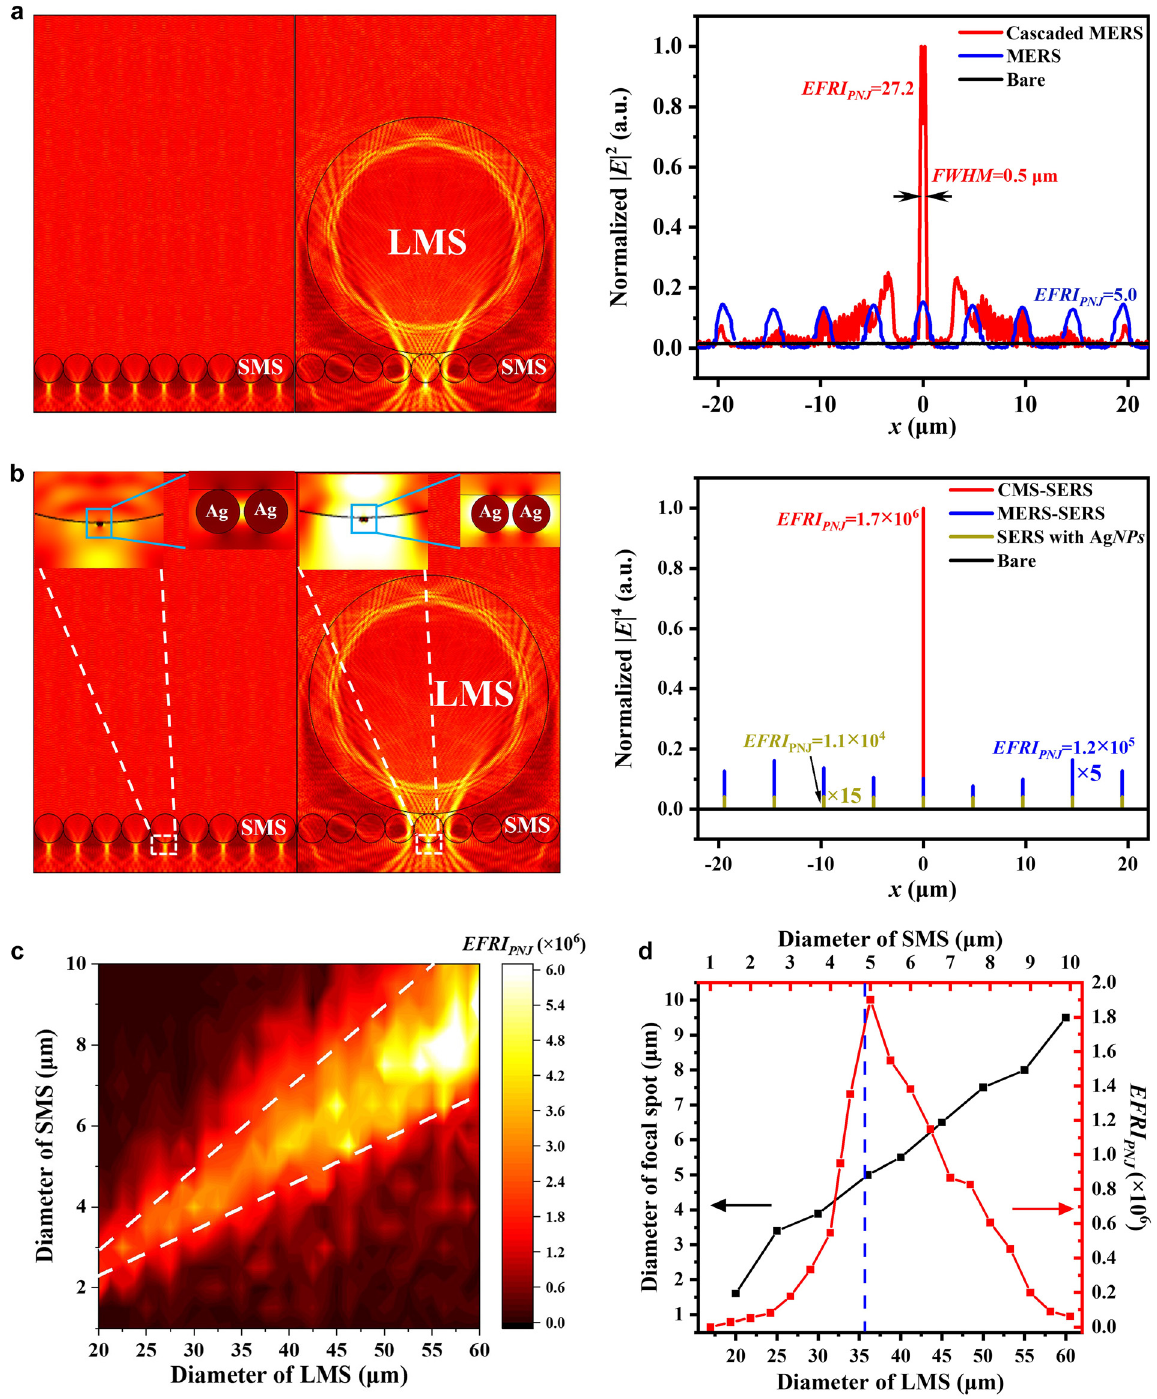
Figure 3: Numerical simulation of PNJs generated by CMS-SERS enhancers with different configurations. (a) Intensity distribution of electric fields focused by MERS and cascaded MERS, and the corresponding EFRI PNJ . (b) Intensity distribution of electric fi eldsfocusedbyMERS-SERSandCMS-SERS,andthecorresponding EFRI PNJ .(c)Evolutionof EFRI PNJ withdiametersofLMSandSMS.(d) Evolutions of focal spot size with LMS diameter and extracted EFRI PNJ with diameter of SMS covered by a 36 μ m-diameter